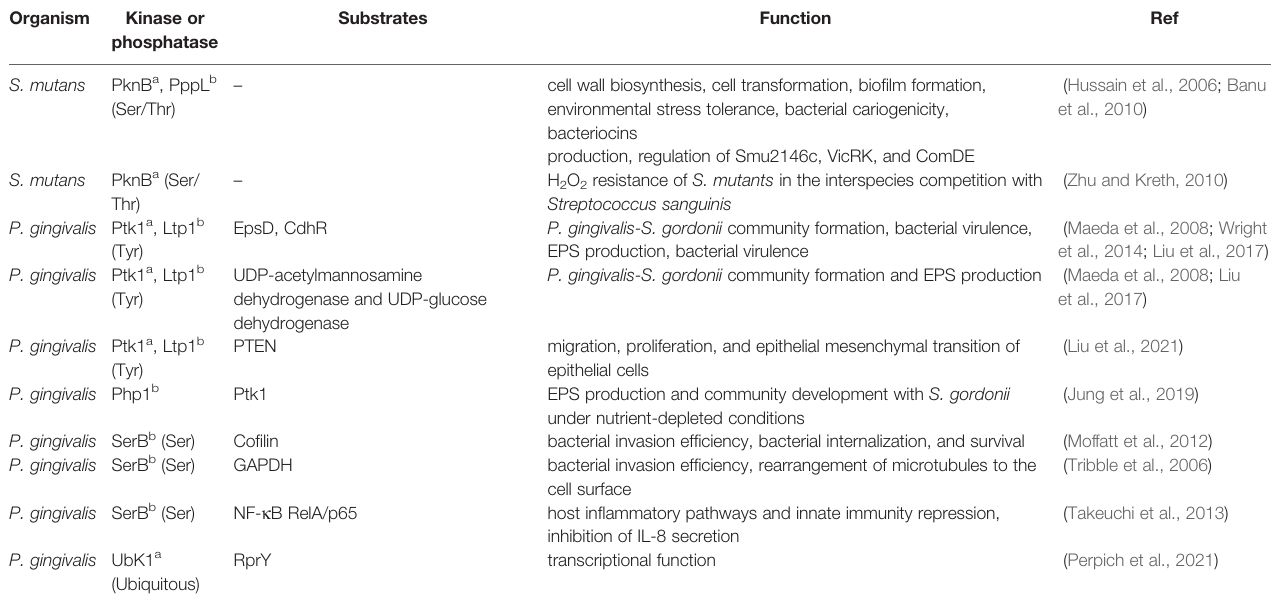
TABLE 1 | Oral bacterial protein kinases and